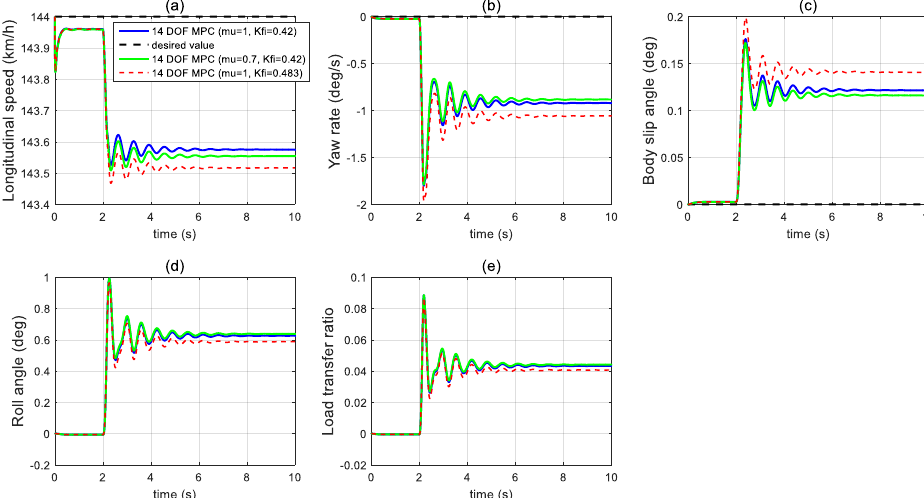
Figure 12. Sensitivity analysis of the dynamics performance of 14 DOF MPC in the first set of simulations ( a ) longitudinal velocity, ( b ) yaw rate, ( c ) body side-slip angle, ( d ) roll angle, ( e ) LTR.